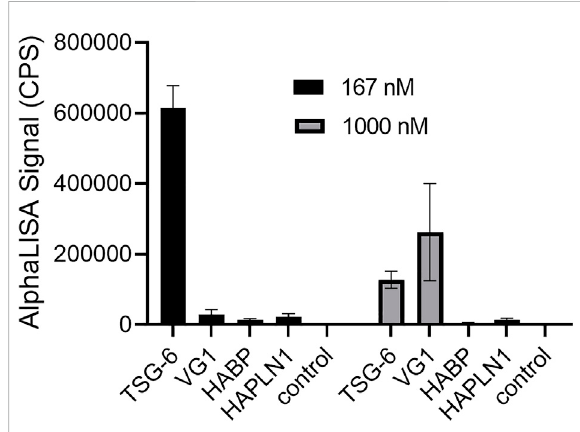
FIGURE 3 Comparison of TSG-6, VG1, aggrecan HABP, and HAPLN1 crosslinking effects on HA reveals that TSG-6 is most effective at a low concentration of 167 nM, while VG1 is more effective than TSG-6 at 1000 nM. HABP and HAPLN1 did not cause signi fi cant crosslinking of HA at either concentration. In the AlphaLISA experiments, end-biotinylated HA at 1 nM fi nal chain concentration was incubated together with protein at the indicated concentration in free solution, then mixed with streptavidin-coateddonorandacceptorbeadsfordetectionofHA crosslinking. The control solution contained bHA and beads only ([protein] = 0). Signal was recorded as counts per second (CPS). Each experiment was repeated at least three independent times, and a representative experiment is shown. Each data point represents the mean ± standard deviation from quadruplicate